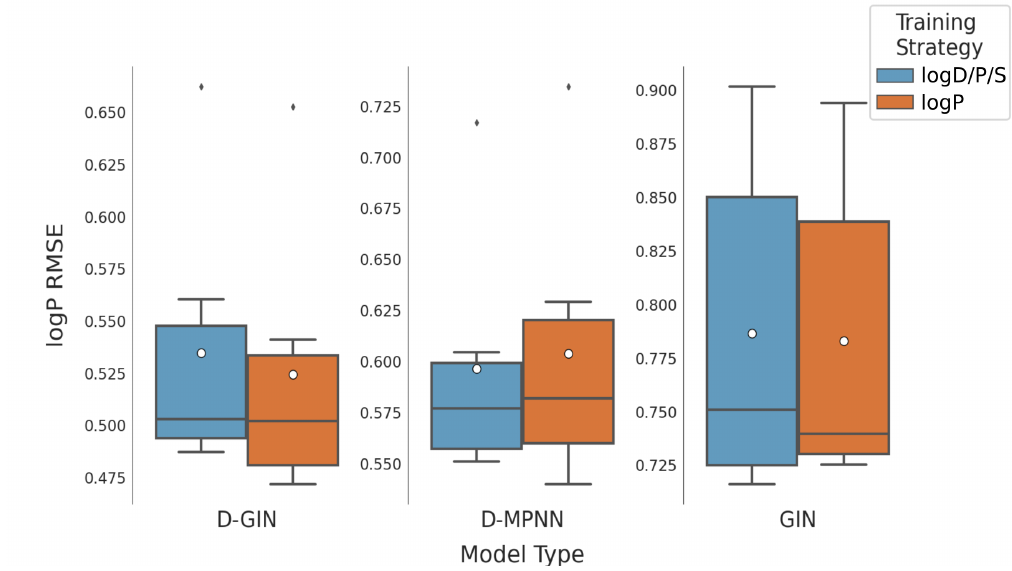
Figure 9. LogP prediction results for all GNN model types according to the used training strategy. Blue box shows the performance of the multi-task training strategy using logD, logS, and logP. The dark orange box shows the results using logP for training. The mean is shown as a white dot, whereas the median is shown as a dark gray line. Exact values are listed in Tables A16–A19 in the Appendix